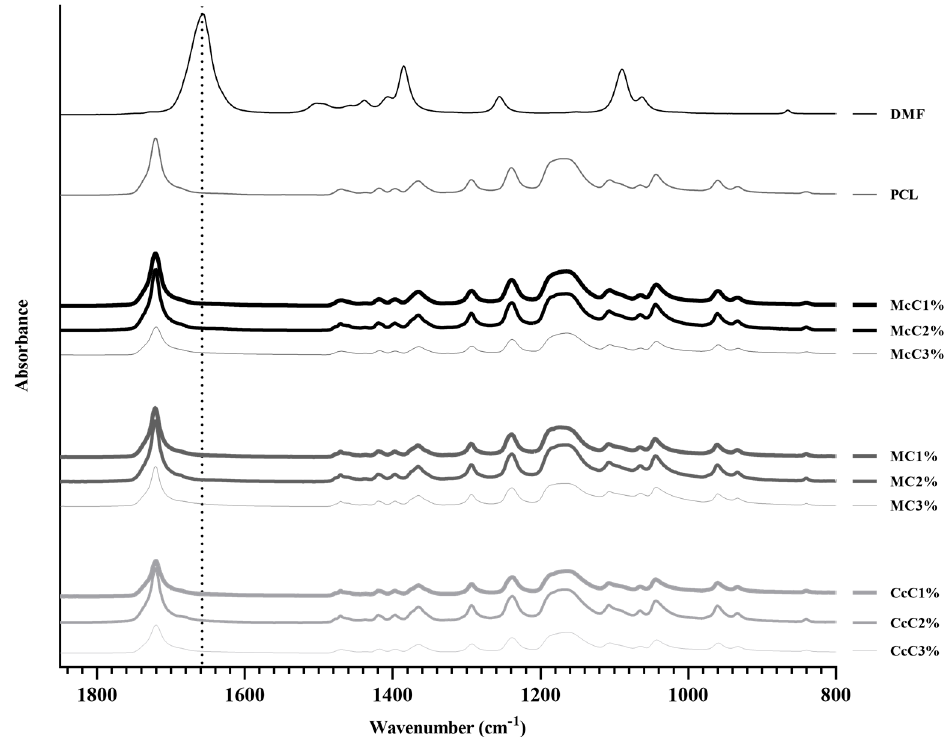
Figure 1. Fourier-transform infrared spectroscopy analysis of all the developed scaffolds: poly( ε - caprolactone) (PCL), microcrystalline cellulose at 1, 2, and 3% (McC1%, McC2%, and McC3%, respectively), methylcellulose at 1, 2, and 3% (MC1%, MC2%, and MC3%, respectively), and corncob cellulose at 1, 2, and 3% (CcC1%, CcC2%, and CcC3%, respectively) and pure DMF.